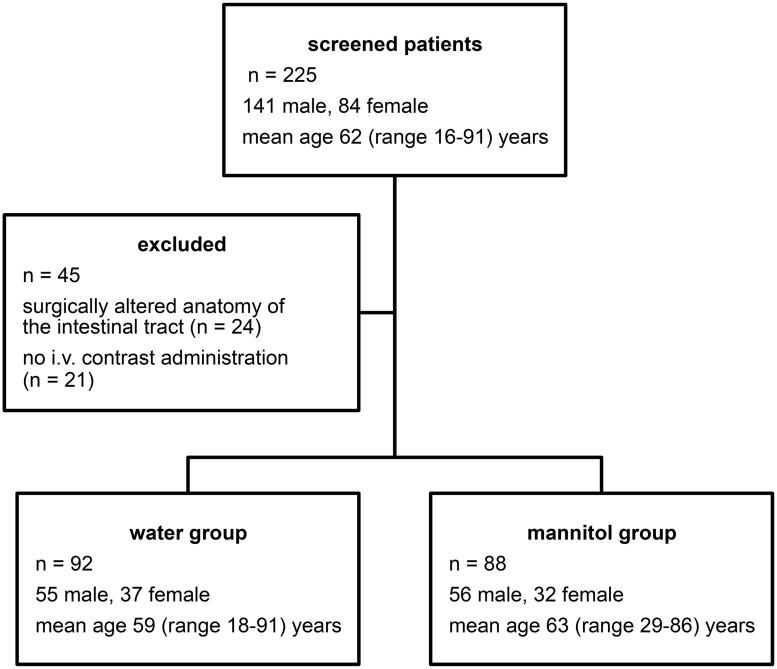
Patient cohort.225 patients referred for abdominal staging CT were screened for possible study inclusion. Consequently, the final study population consisted of 180 patients.